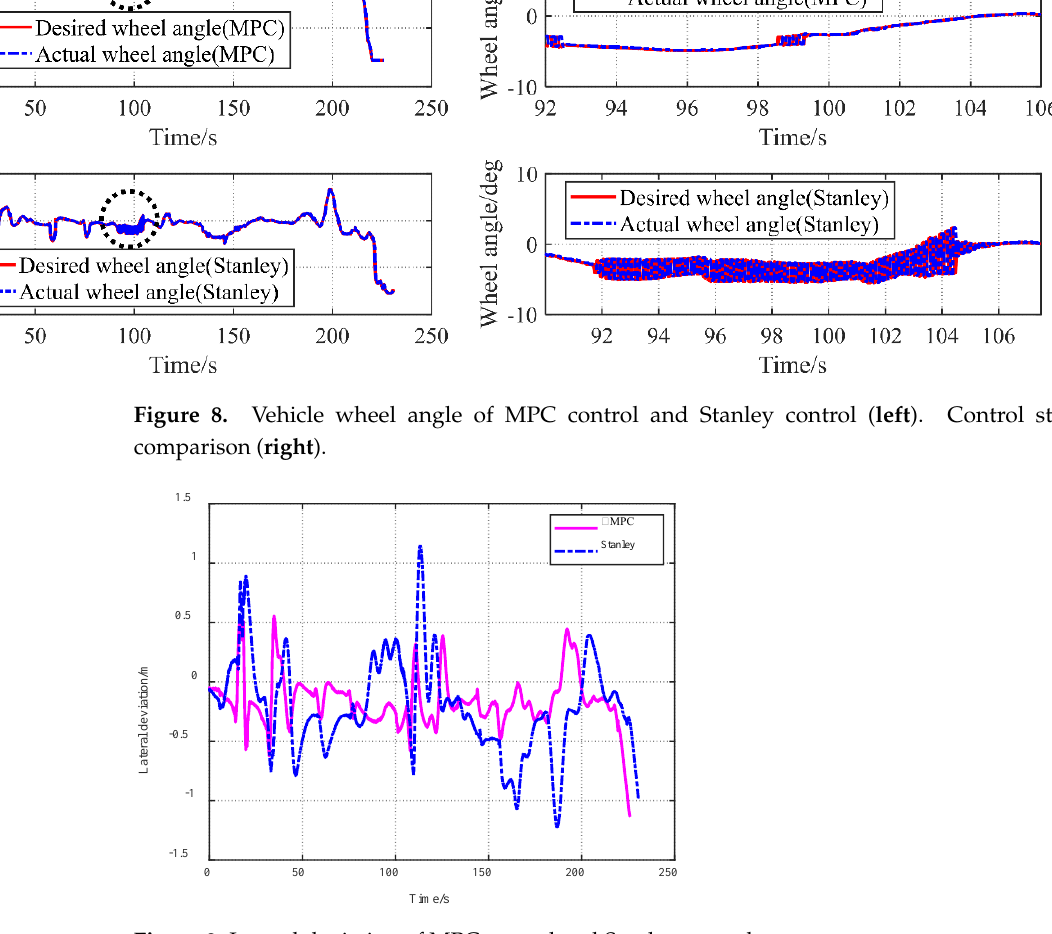
Table 1. Lateral error test results. Working Condition